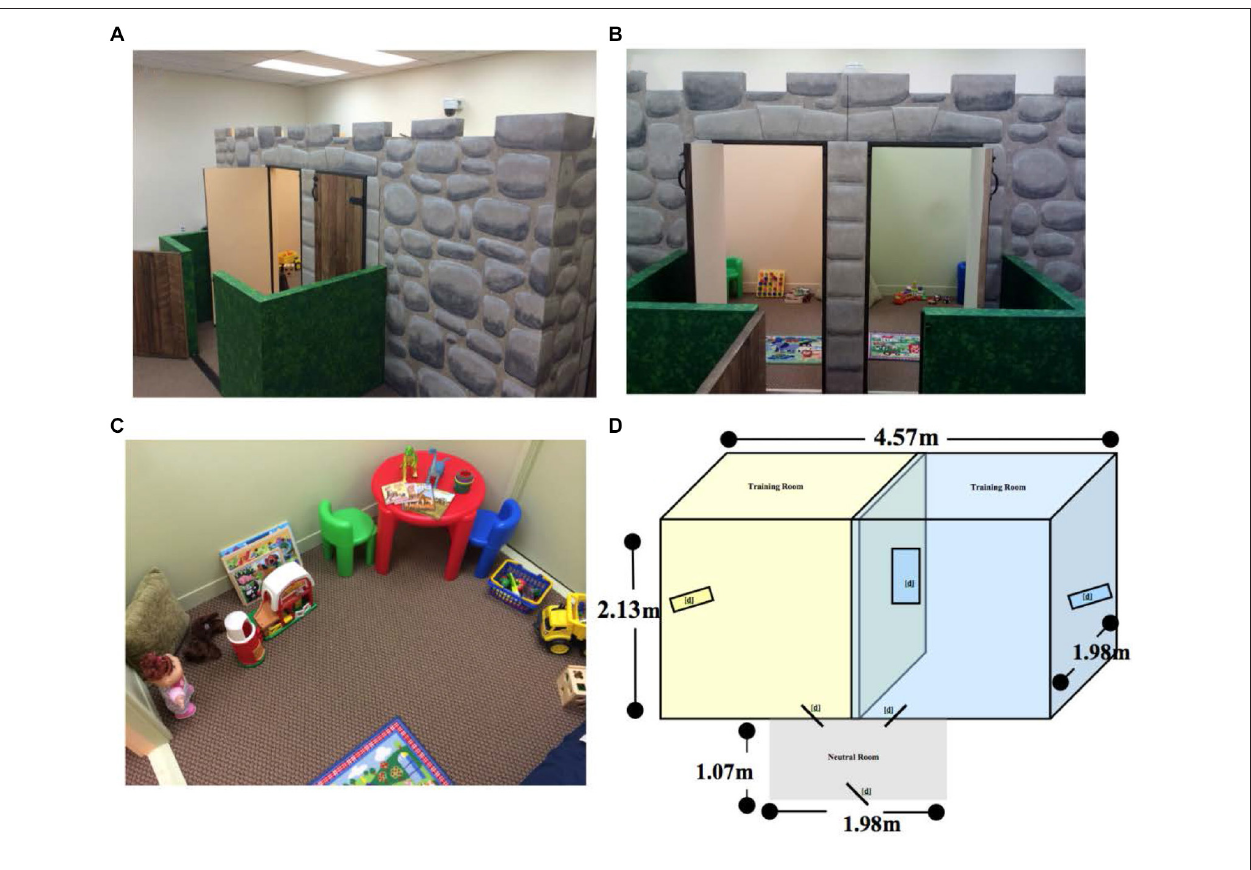
the child has to decide which of the two rooms they want to enter first. (C) Overhead view of one room in the castle arena. (D) Blueprint design of the physical dimensions of the custom-designed arena. [d] =